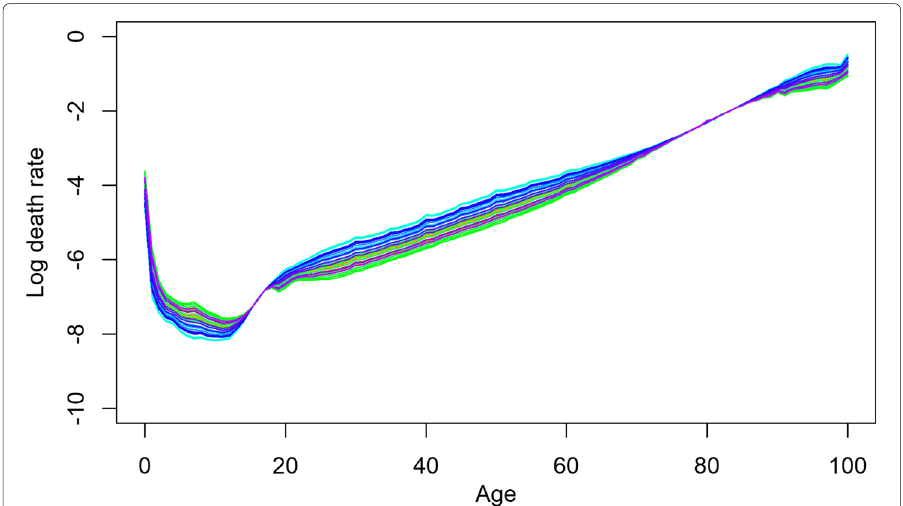
Fig. 9 Fitted log mortality rates for combined mortality data of (comparatively) high mortality countries. Years are plotted using a rainbow palette as before